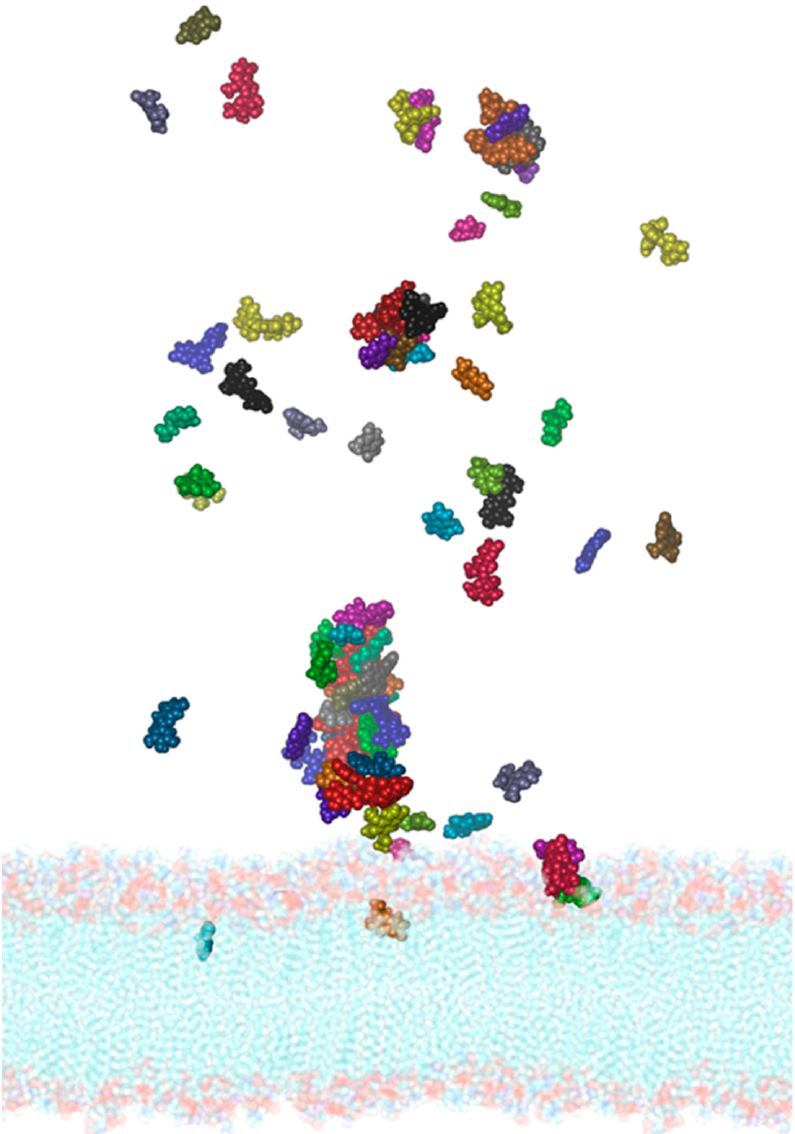
Figure 7. Molecular representation of the membrane- PEL compounds system after 150 ns of simu- lation time. The different colors of the spheres indicate different compounds. From the transparent side view, it is possible to observe the entry of dihydrobenzoic acid (cyan), of vanillic (gray) and homovanillic acid (purple), of scopoletin (orange), of vitexin (green), of isofraxoside (red), and gallocatechin (lilac). These effects become more evident by projecting the thickness of the membrane on a plane, as shown in Figure 9. In this representation, the average thickness of the membrane, indicated by the color scale that goes from white to dark green, has been plotted as a function of the transverse plane of the membrane itself for the simulated system in the presence (A) and absence of the compounds (B). Through this representation, it can be observed that the increase in thickness is more marked in proximity of the entry sites or surface contact of the compounds, identified by the red circles. However, the effect seems extended to the entire membrane, suggesting that the compounds can deeply interfere with the dynamics of the lipid bilayer, suggesting a possible modulatory effect on the dynamics of the proteins inserted in the